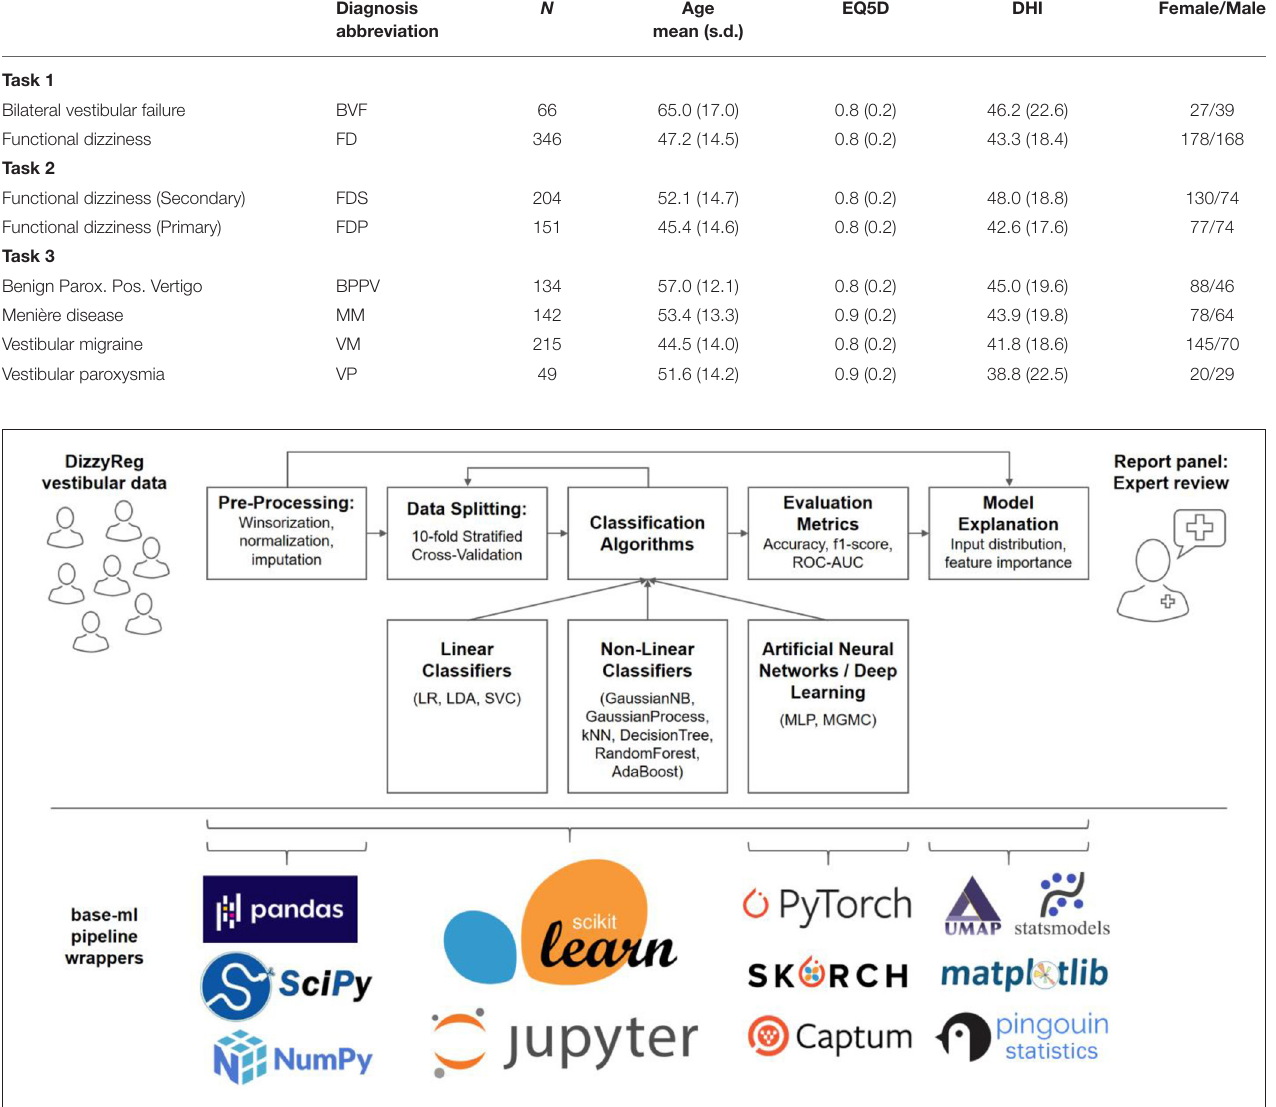
FIGURE 1 | Components and methods of the classification workflow applied to vestibular data in DizzyReg. Raw tabular data is pre-processed and split into 10-folds for stratified cross-validation and for estimation of prospective classification performance. Various linear, non-linear and neural classifiers are repeatedly trained on all folds in the data, the evaluation is performed with various classification metrics. The metrics, along with model explanations, are presented to experts in form of a report panel, who can review the classification outcome and model performance. All pipeline components are implemented in base-ml, a comprehensive software tool which we provide open-source to the vestibular community as a starting point for similar studies. Implemented in Python, and centered around scikit-learn, it comprises various modules for data science, machine learning, descriptive statistics, explainable AI and visualization. Details on base-ml are described in section Base-ml